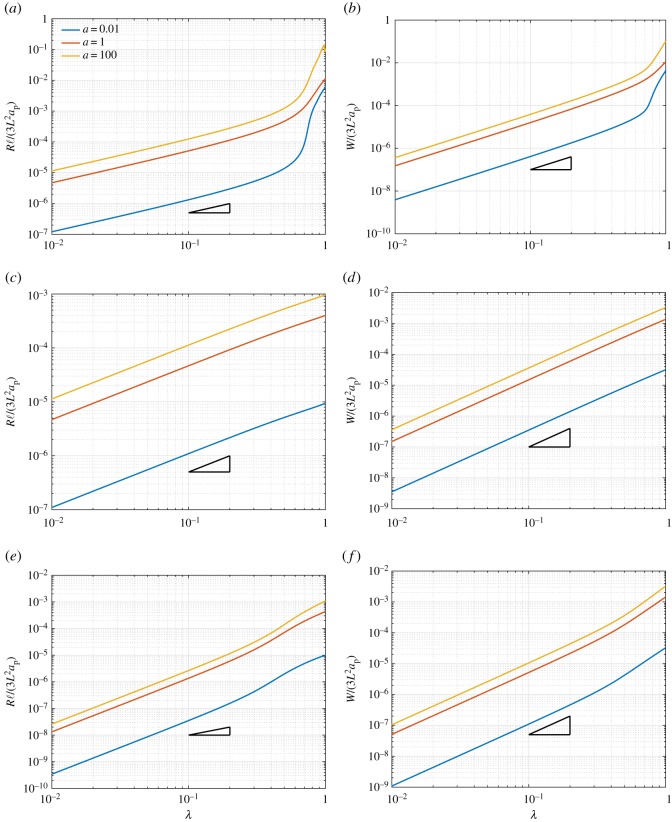
Extension, shear and bending tests: non-dimensional structural reaction in the x-direction Rℓ/(3L2ap) (a,e) and the y-direction Rℓ/(3L2ap) (c) and non-dimensional global strain energy W/(3L2ap) evolution (b,d,f) varying a=ak/ap and taking u1max=75 for the extension test (a,b), u2max=75 for the shear test (c,d) and u1max=35 for the bending test (the black triangle indicates the slope of the linear law for the structural reaction and the quadratic law for the strain energy).